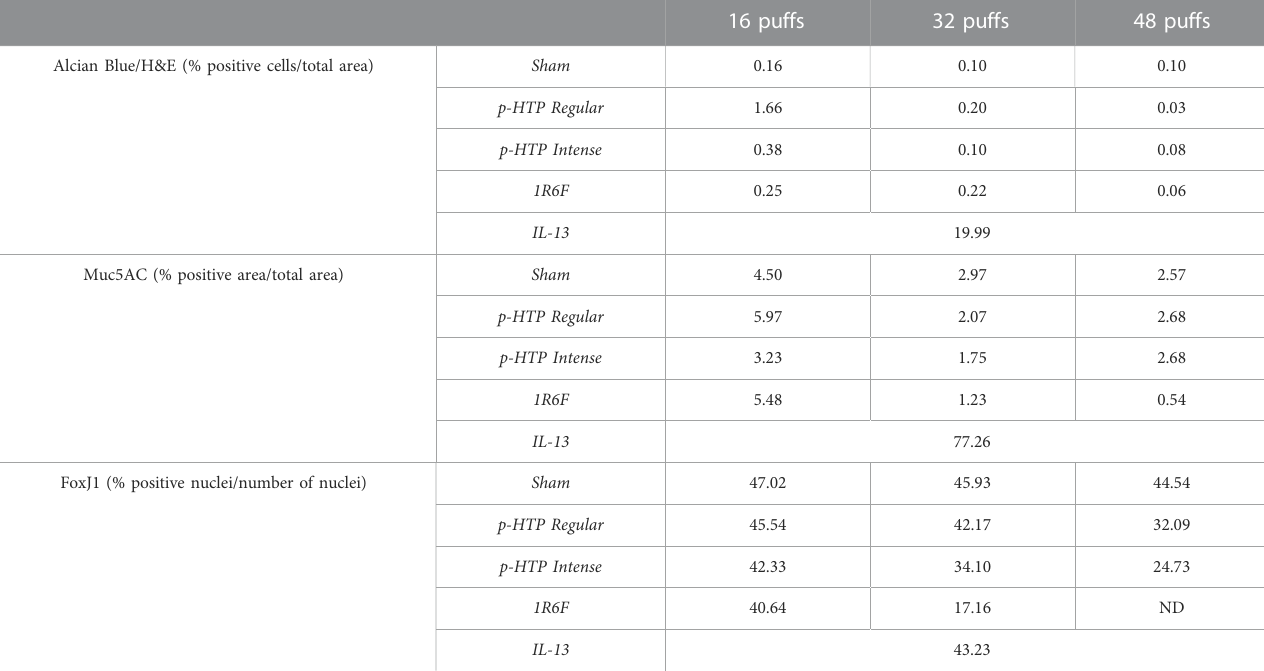
TABLE 1 Average staining intreated tissues (16, 32 or 48 puffs of air (Sham), p-HTP Regular, p-HTP Intense, 1R6F), fi xedandstained at the end of the 28 days repeated exposure period. Positive control treatment, IL-13, is also included. ND: no staining detected. 16 puffs 32 puffs 48 puffs Alcian Blue/H&E (% positive cells/total